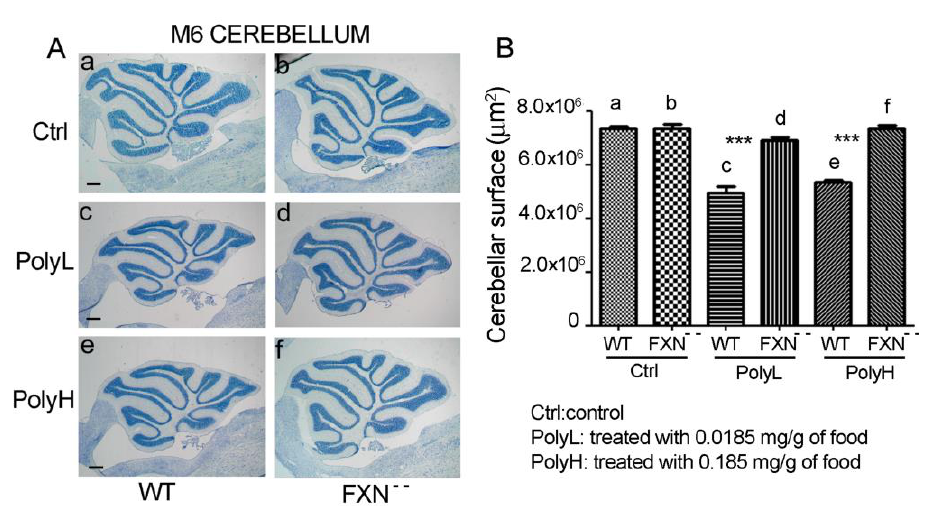
Figure 1. ( A ): Cerebellar phenotype of six-month-old wild type (WT) mice (a,c,e) and of littermates carrying the Frataxin gene mutation in homozygosis (FXN -- ) (b,d,f) in either control conditions (Ctrl, A (a,b)) or in the presence of EpiGalloCatechinGallate (EGCG) administration under low (PolyL: 0.0185 mg / g, c,d), or high (PolyH; 0.185 mg / g, e,f) dosage conditions. For each measure, 5 animals were used arising from either WT and FXN -- genotypes. Scale bar: 500 µm. ( B ): Results of the